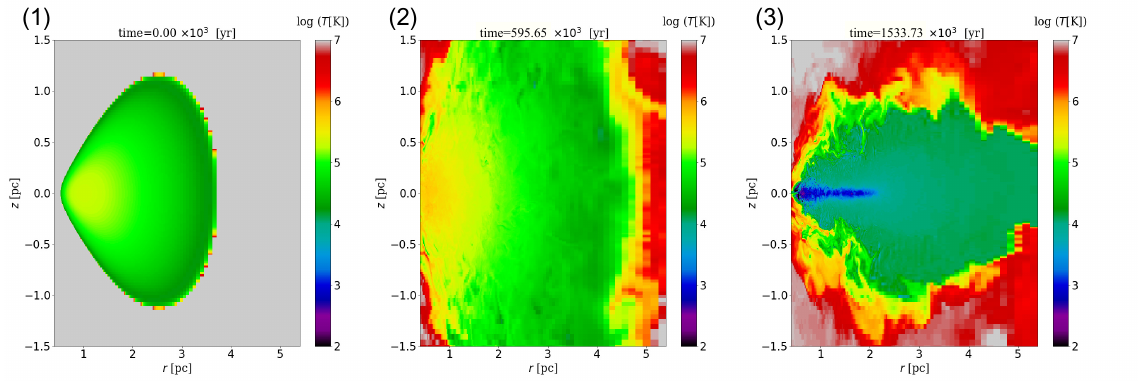
Figure 1. Time evolution of the model of N ϕ = 512 in the slice of rz-plane. Color contour denotes temperature. Snapshots are ( 1 ) t = 0.00 [Myr], ( 2 ) t = 0.60 [Myr], and ( 3 ) t = 1.53 [Myr].